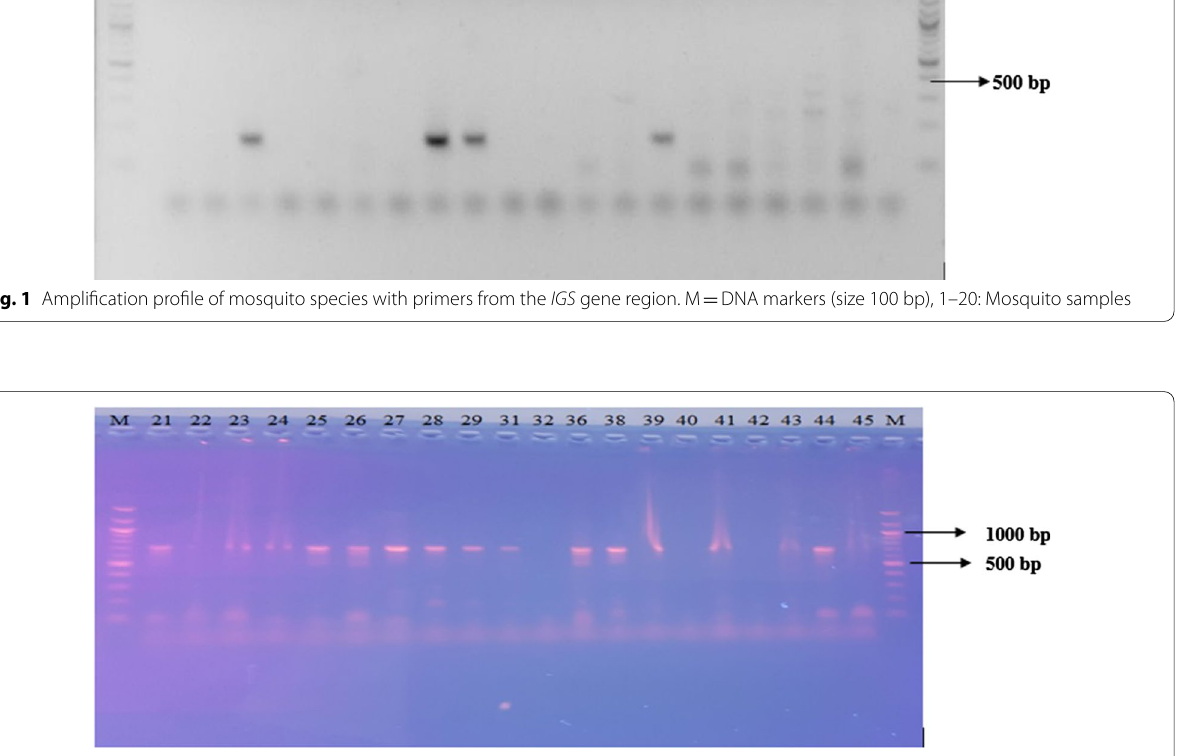
DNA markers (size 100 bp), 21–45: Mosquito =